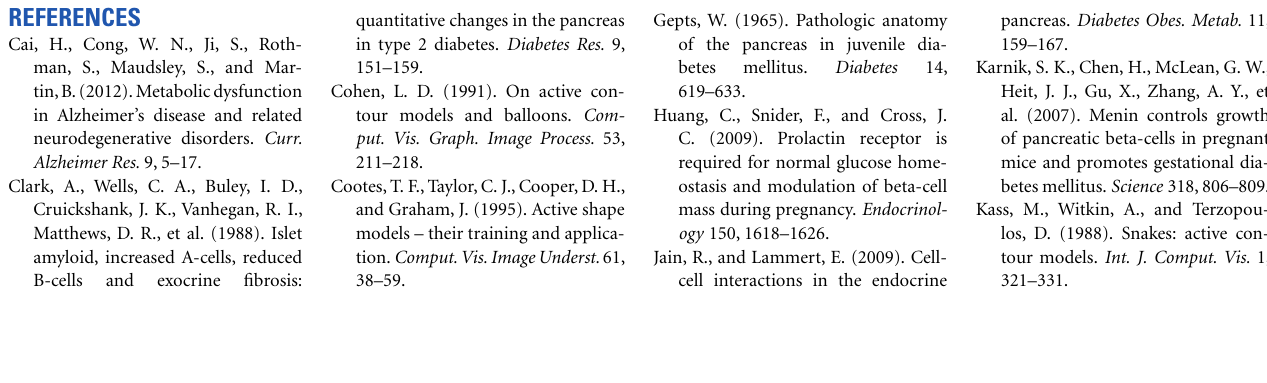
FIGURE 6 |Analysis of pancreatic islets from normal and diabetic primates using Pancreas ++ , MATLAB and manual method. (A,B) Are representative images of pancreatic islets from normal and diabetic primates respectively. (C) Shows the time that Pancreas ++ , MATLAB, and manual method take to analyze the same images.The diabetic primate had significantly higher total alpha-cell area (E) ; total alpha-cell numbers (F) ; alpha-cell percentage (G) , lower beta-cell percentage (H) , but similar islet area (D) compared to the normal primate analyzed by Pancreas ++ .